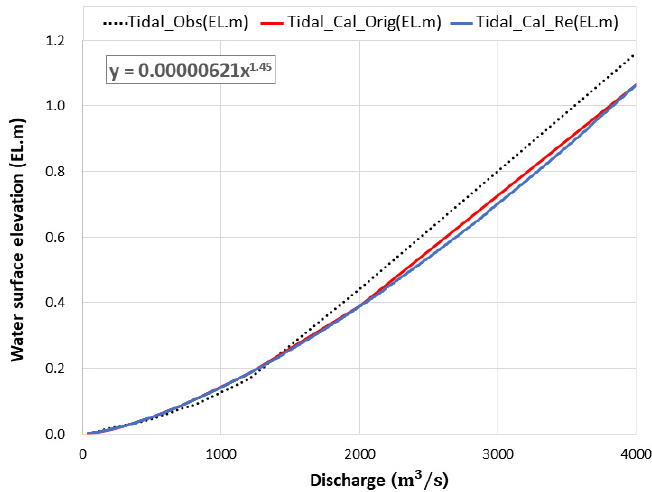
Figure 3. Relationship between the river discharge and the water level (in the regression equation, x and y refer to the discharge and water surface elevation, respectively).